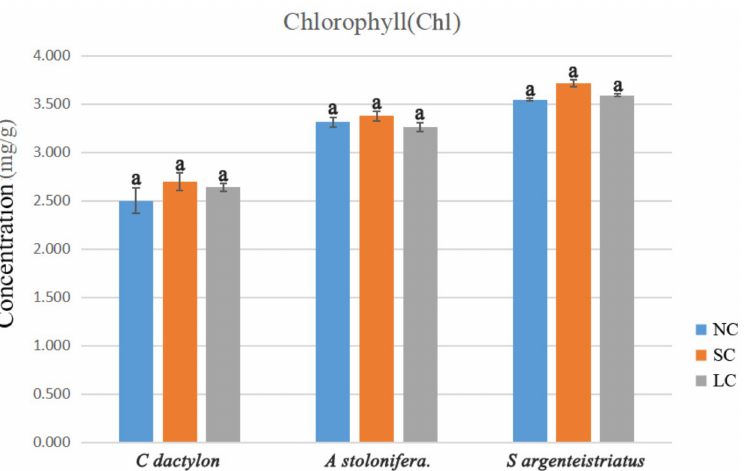
Figure 10. Graph of Chlorophyll concentrations. Note: Different normal letters indicate significant differences among treatments ( p <